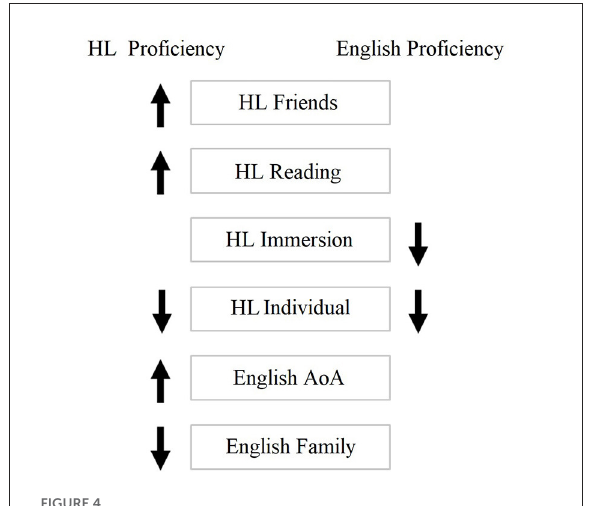
FIGURE4 Overview of heritage language (HL) and English experience effects on self-reported HL and English proficiency. t (163) = − 2.97, p = 0.003] than Spanish bilinguals [AoA: Estimate = 0.07, SE = 0.13, t (163) = 0.50, p = 0.62; Family: Estimate = − 0.13, SE = 0.12, t (163) = − 1.02, p = 0.311; see Figures 2A,B, respectively].